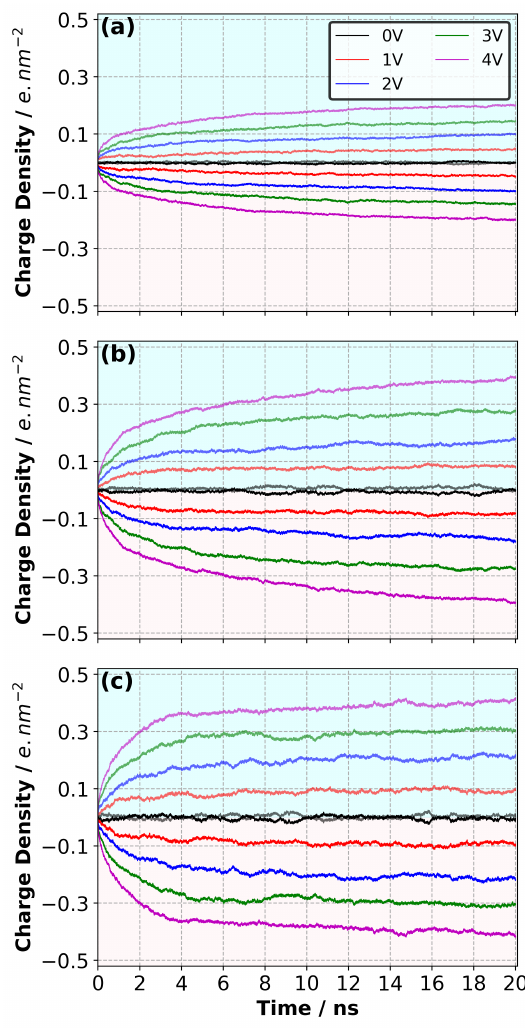
Figure 4. Evolution of charge density distribution on the electrodes as a function of potential difference at ( a ) 300 K, ( b ) 400 K and ( c ) 500